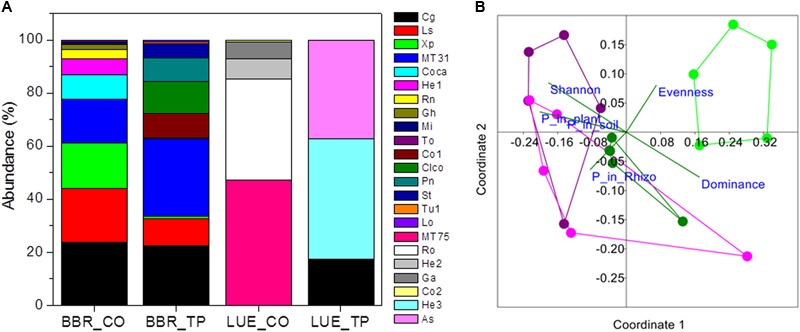
Relative abundance of ectomycorrhizal fungal taxa colonizing root tips of beech trees in P-rich (BBR) or P-poor soil (LUE) without [Control (CO)] or with application triple superphosphate (TP) fertilizer (A) and non-metric multidimensional scaling (NMDS) of the fungal assemblages (B). Stress: 0.194. Vectors indicate explanatory variables with the diversity indices (Shannon H, Evenness, and Dominance) and P contents (whole-plant P content, P content of soil, and P content of rhizosphere). Symbols refer to ectomycorrhizal communities from BBR_CO: pink, BBR_FP: purple, LUE_CO: light green, LUE_FP: dark green. In (A) abbreviations refer to the following fungal taxa: Cg, Cenococcum geophilum; Ls, Lactarius subdulcis; Xp, Xerocomellus pruinatus, MT31; Coca, Cortinarius casimiri; He1, Helotiales sp. 1; Rn, Russula nigricans; Gh, Genea hispidula; Mi, Melanogaster intermedius; To, Tomentellopsis sp.; Co1, Cortinarius sp_1.; Clco, Clavulina coralloides; Pn, Pachyphlodes nemoralis; St, Solicoccozyma terricola; Tu1, Tuber sp.; LO, Leptodontidium orchidicola, MT57; Ro, Russula ochroleuca; He2, Helotiales sp. 2; Ga, Genea cf. anthracina; Co2, Cortinarius sp. 2; He3, Heliotales sp. 3; As, Ascomycota; MT, morphotypes, for which sequencing failed.